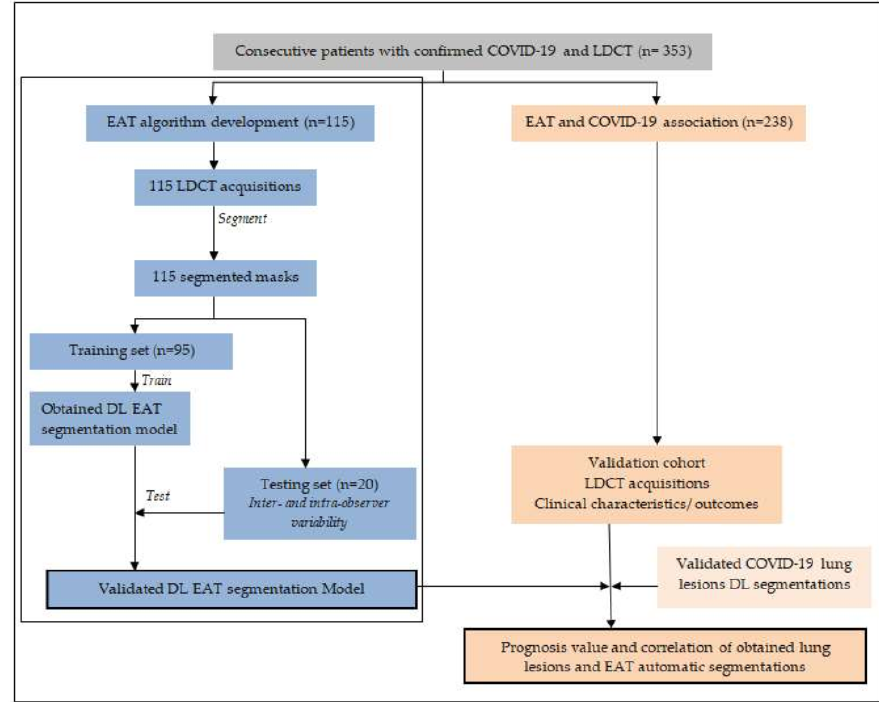
Figure 1. Study flow chart. LDCT: low-dose chest computed tomography; EAT: Epicardial adipose tissue pericardial volume; DL: Deep-